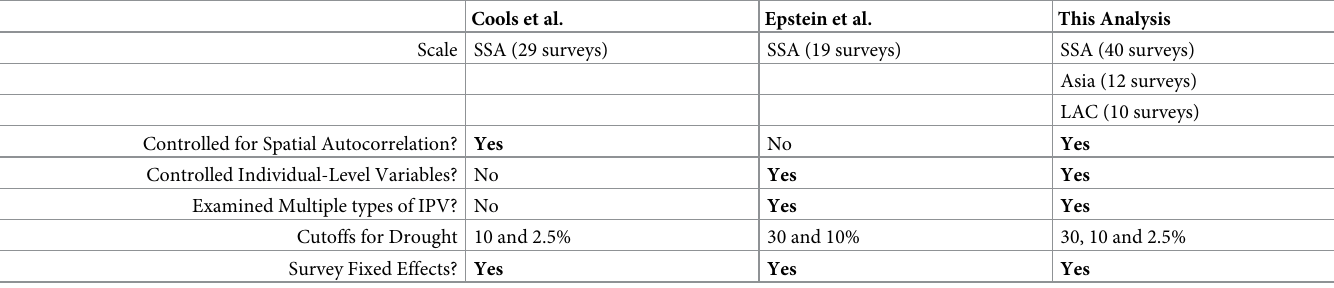
Table 1. Comparison of methods used between Cools et al., Epstein et al., and this analysis. Cools et al. Epstein et al. This